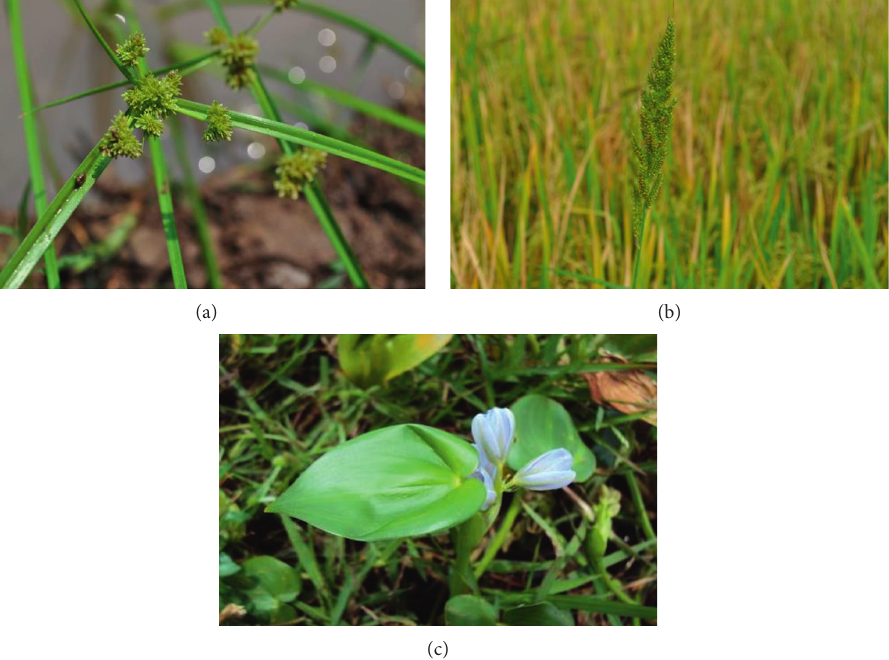
Figure 1: Commonly found weeds in paddy fields. (a) Sedges ( Cyperus difformis ), (b) grass ( Echinochloa crus-galli ), and (c) broadleaved weed ( Monochoria vaginalis